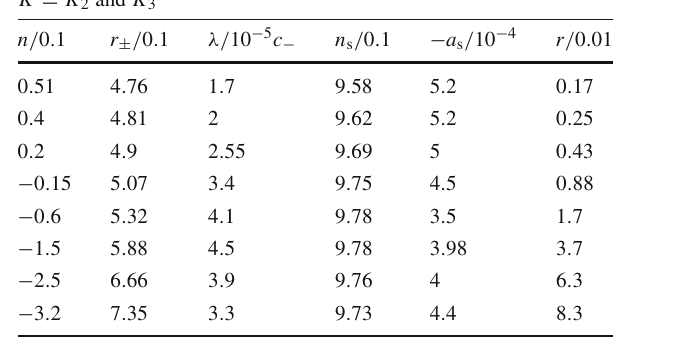
for | n s | < 0 . 1, i.e., the Starobinsky-like region. Hill- top IGHI is attained for n > 0 and there we find (cid:2) 0 . 155, where (cid:13) (cid:13) max (cid:14) max (cid:14) increases as n drops. The required tuning is not severe, mainly for n < 0 . 04 since (cid:2) 20%. Since our models predict r (cid:2) 0 . 0017, (cid:13) max (cid:14) they are testable by the forthcoming experiments, like Bicep3 [60], PRISM [61], LiteBIRD [62] and CORE [63], which are expected to measure r with an accuracy of 10 − 3 . We do not present in Table 2 φ (cid:14) values since, as inferred by Eq. (58), every φ (cid:14) satisfying Eq. (41a) leads to the same ratio λ/ c − . For the reasons mentioned below Eq. (56), we prefer φ (cid:14) ≤ 1. To achieve this, we need c − (cid:2) ( 30 − 140 ) for K = K 1 and c − (cid:2) ( 40 − 160 ) for K = K 2 or K 3 , where the variation of c − is given as n decreases. For K = K 1 we expect similar values for λ/ c − and the